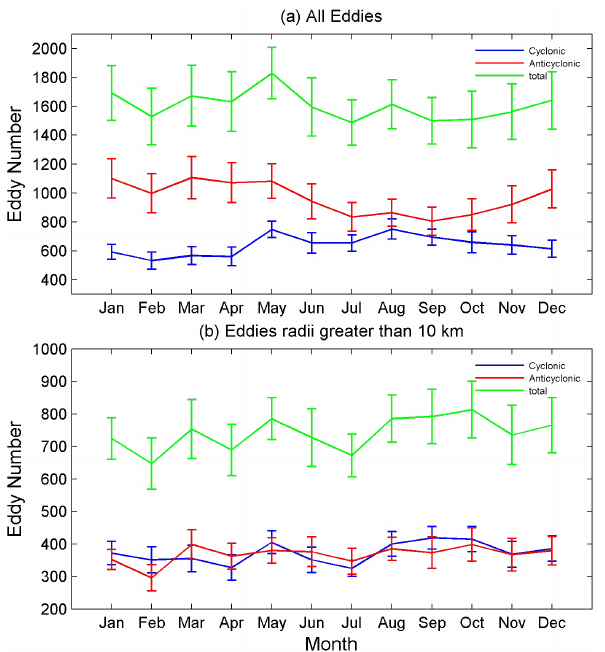
Figure 11. (a) The number of eddies as a function of the calendar months for cyclonic (blue), anticyclonic (red), and both types of eddies (green). The bars indicate the standard error of eddy number estimates. (b) as in (a) , but for mesoscale eddies with radius larger than 10km.